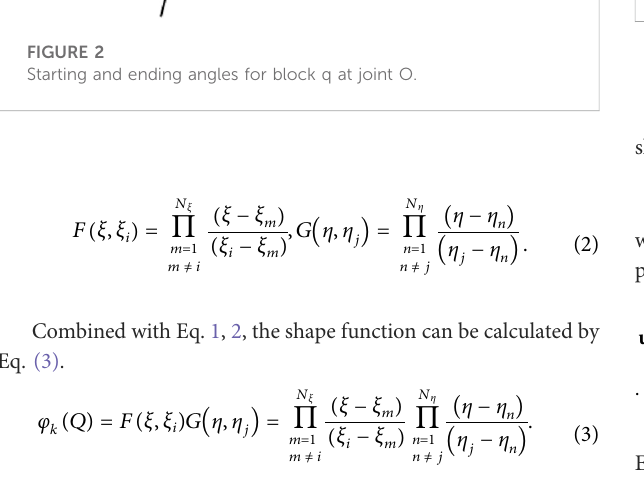
FIGURE 4 Mechanical model of the cement concrete